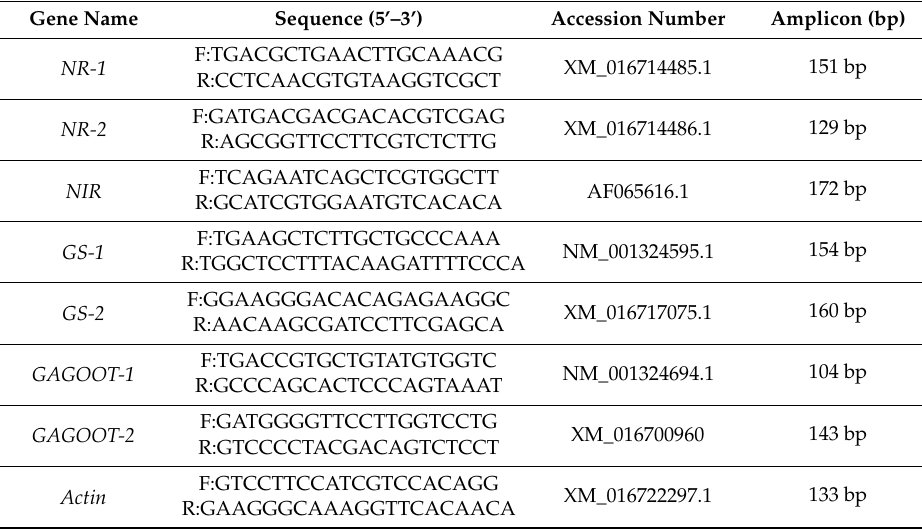
Table 3. The list of primer sequences and Gene Bank accession number used in this study for the